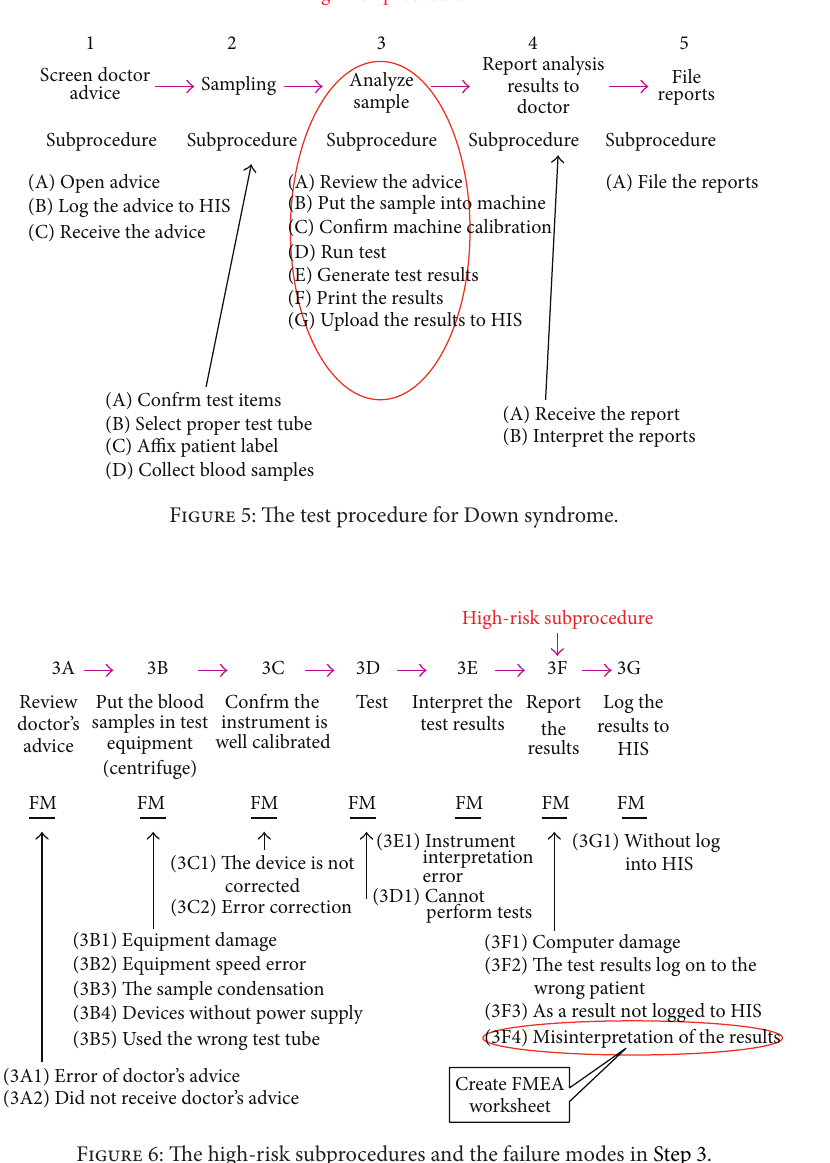
Figure 6: The high-risk subprocedures and the failure modes in Step